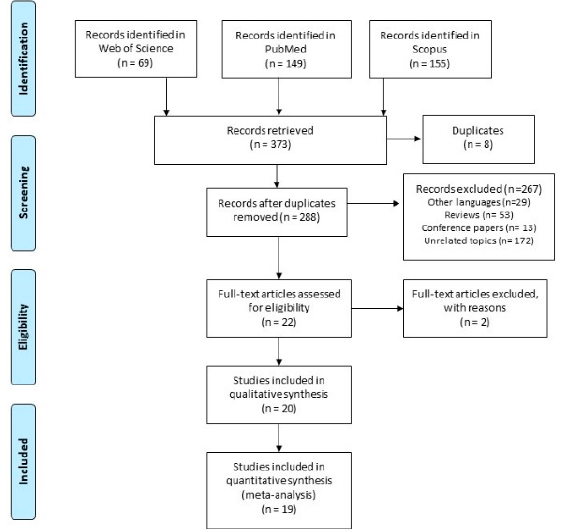
Figure 1. Flow diagram of the selection process.